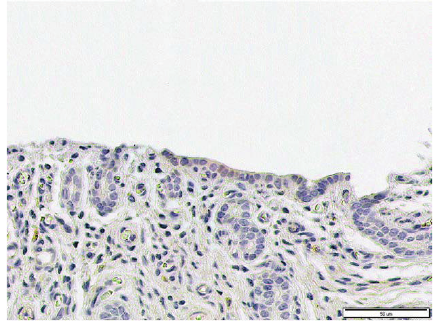
Figure 8: Isotype control with a nonimmunized rabbit serum at a dilution of 1: 25. No positive signals are observed in the feline